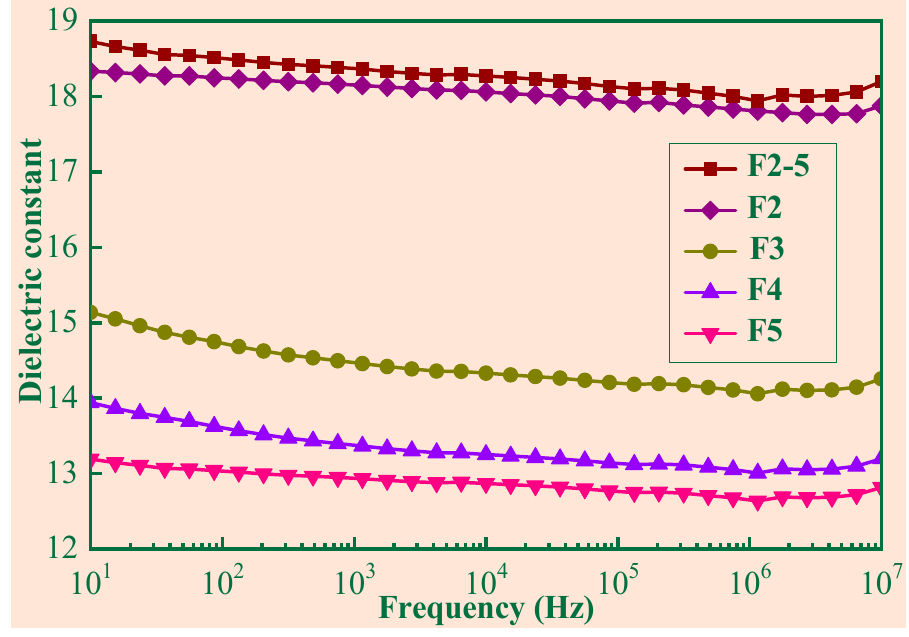
Figure 6. The dielectric constant of the SR/Gr(3 wt%) composites.